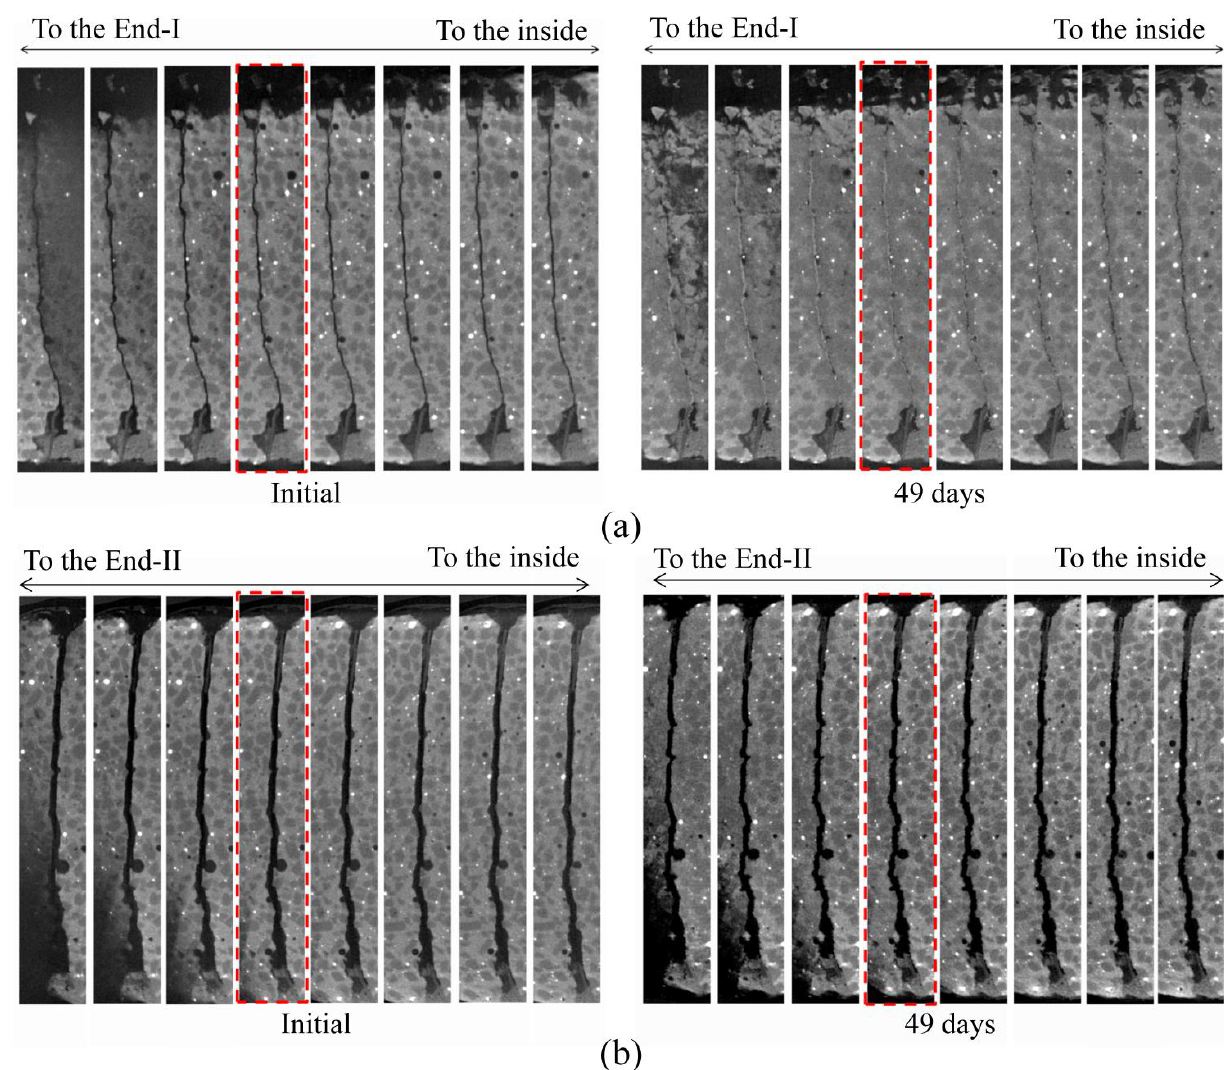
Figure 3. Comparison of CT images of macro-fracture at initial stage and after being kept in seawater for 49 days for ( a ) End-I and ( b ) End-II. Height and width of each image are 14 and 2 mm, respectively. Note that the red dashed lines correspond to the top cross sections of each region of interest (ROI) in Figure